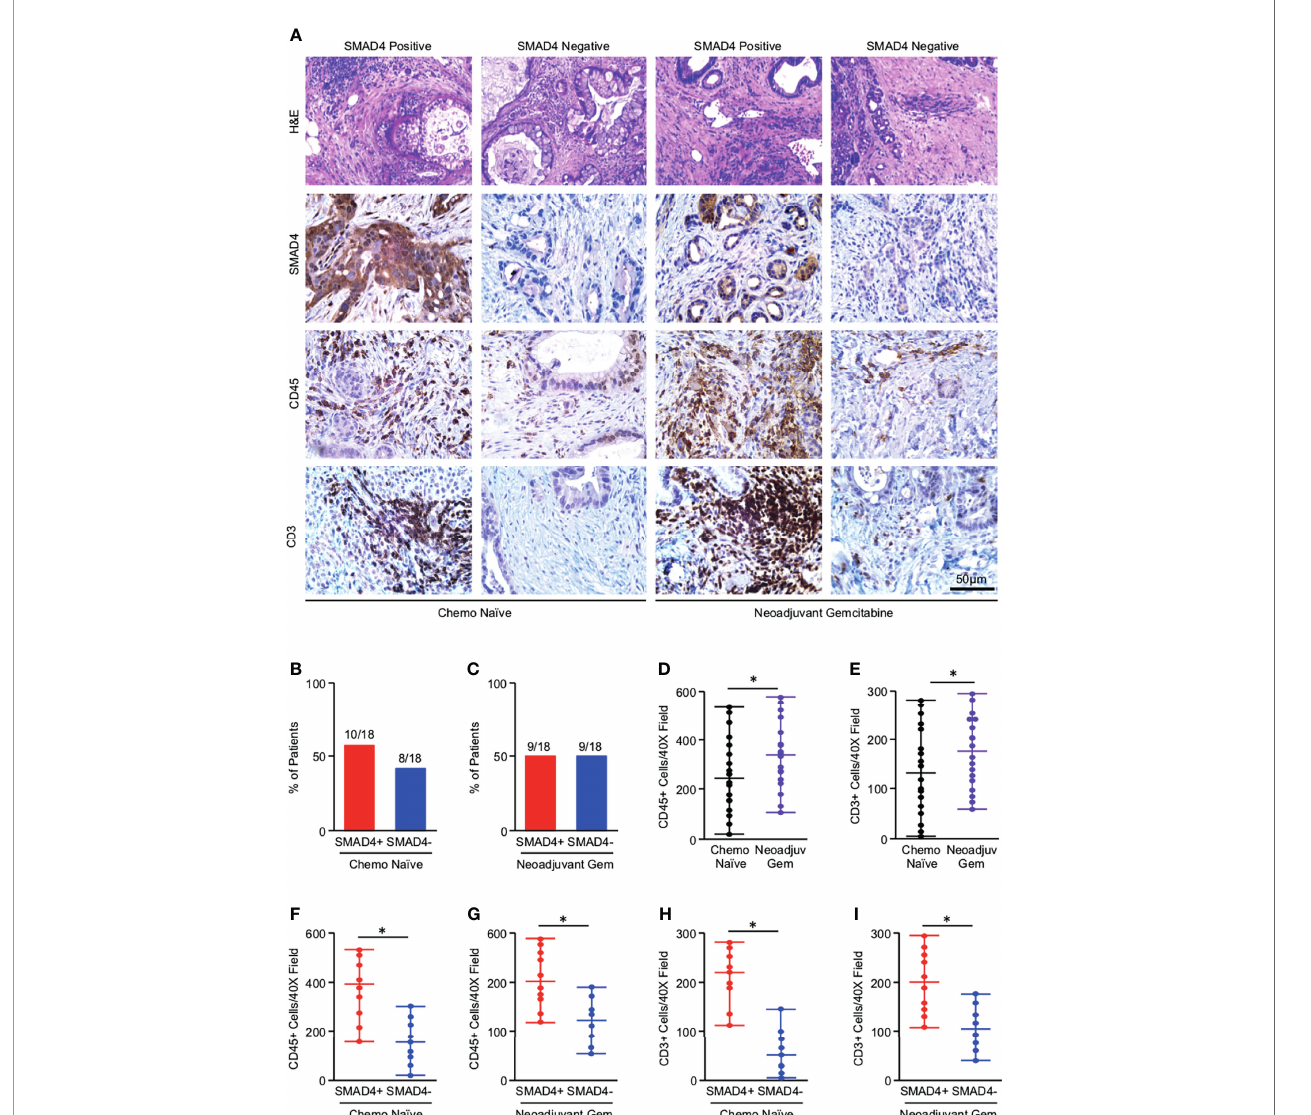
FIGURE 1 | Tumors with loss of SMAD4 display reduced lymphocyte in fi ltration independent of neoadjuvant chemotherapy status. (A) Excisional biopsies from 36 PDAC patients were sectioned and stained either with H&E or via immunohistochemistry for SMAD4, the pan-leukocyte antigen CD45, or T-cell marker CD3 and representative images shown for each from either chemotherapy naïve patients (N=18) or patients who had received neoadjuvant Gemcitabine-based chemotherapy (N=18). (B, C) The percent of patients from either the chemo-naïve or neoadjuvant Gemcitabine group that was either SMAD4-expressing (SMAD4+) or SMAD4-non- expressing (SMAD4-). (D, E) The number of CD45+ or CD3+ cells per 40X fi eld was quanti fi ed by three blinded investigators, related to chemotherapy status, and displayed as an individual value plot. Using these values, the number of CD45 positive cells was next related to SMAD4 status in either (F) the chemo naïve group or (G) the neoadjuvant Gemcitabine group and displayed as an individual value plot. (H, I) The number of CD3+ T-cells were quanti fi ed as described and related to SMAD4 status in either the chemo-naïve group or the neoadjuvant Gemcitabine group and displayed as an individual value plot. (*p <